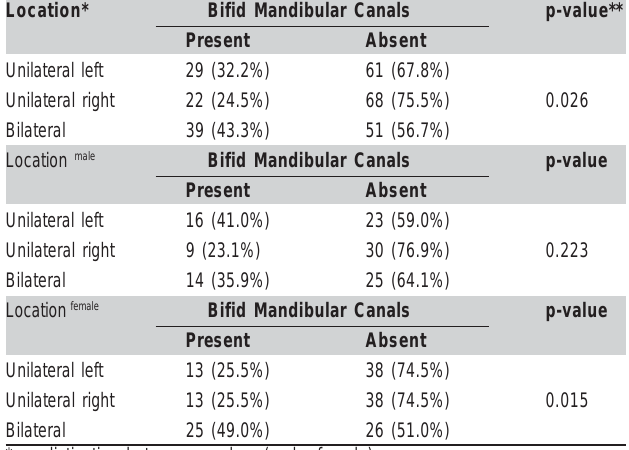
Table 3 - Absolute (n) and relative (%) frequencies of bifid mandibular canals in CBCT images according to location